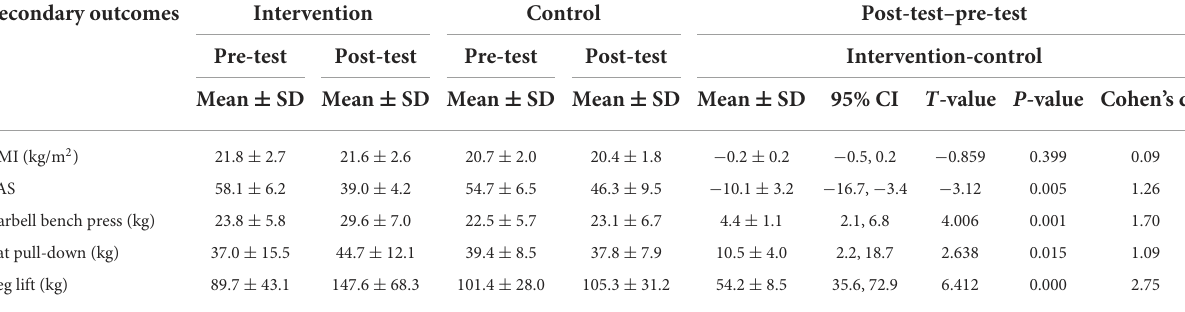
TABLE 4 Differences of mean BMI, muscle strength, and anxiety level compared with the control